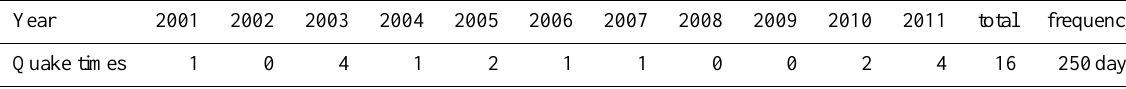
Table 1. Number of earthquakes (M ≥ 5.0) from 2001–2011 in southern Iran.